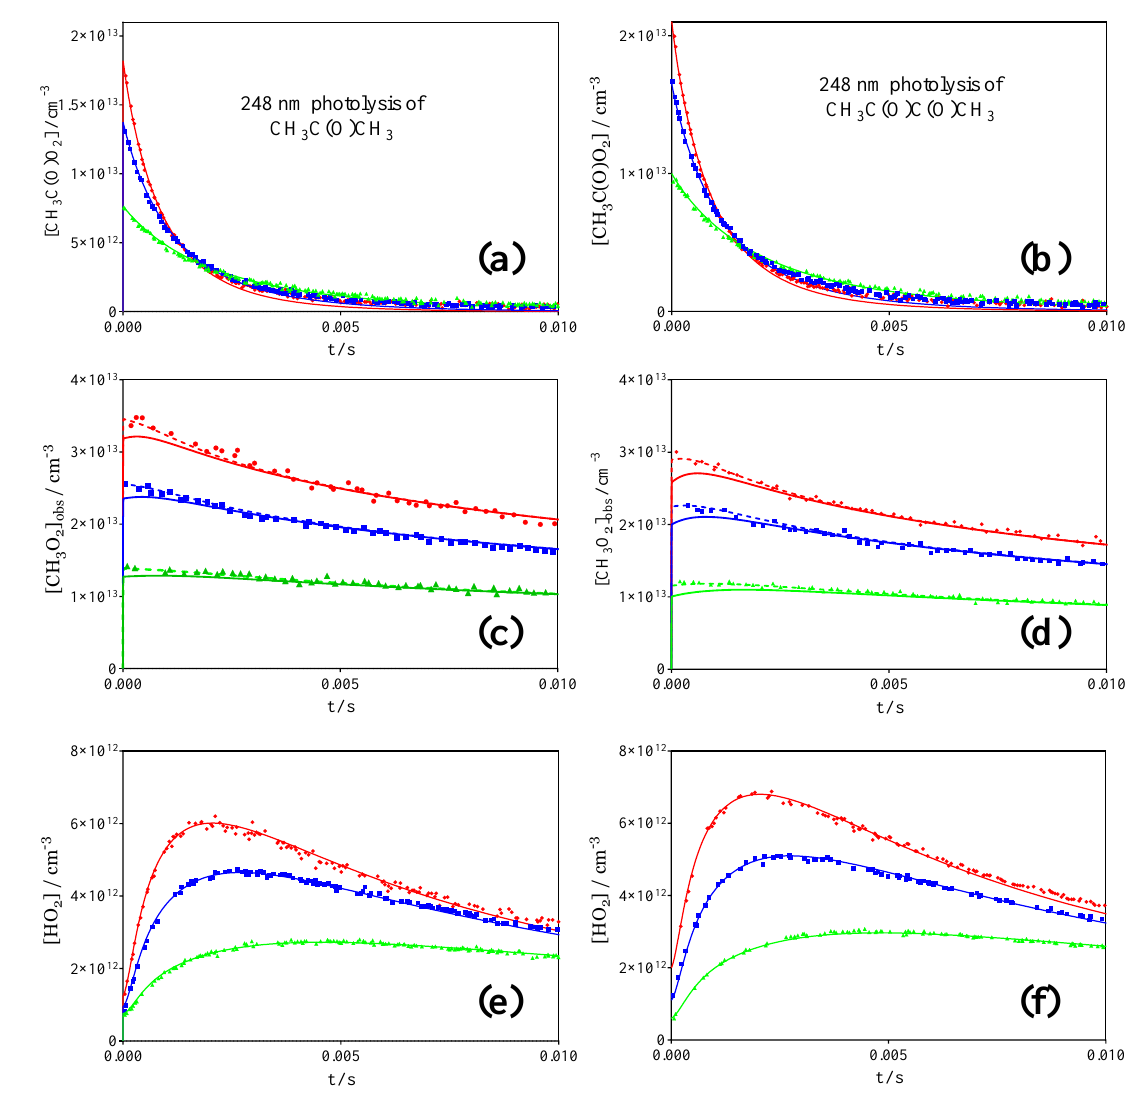
Figure 6. Concentration-time profiles of CH 3 C(O)O 2 • ( a , b ), CH 3 O 2 • ( c , d ) et HO 2 • ( e , f ) measured simultaneously following the 248 nm photolysis of 3 different concentrations of CH 3 C(O)CH 3 [CH 3 C(O)CH 3 ] = 1.21 (red), 0.86 (blue) and 0.4 × 10 16 cm − 3 (green) (left raw) and CH 3 C(O)C(O)CH 3 [CH 3 C(O)C(O)CH 3 ] = 6 (red), 2.56 (blue) and 0.93 × 10 16 cm − 3 (green) (right raw) in 100 Torr O 2 . Full lines: simulation following the model and rate constants as given in Table 3. For the [CH 3 O 2 • ] profiles, the dashed lines show [CH 3 O 2 • ] + 0.179 × [CH 3 C(O)O 2 • ]. Experimental HO 2 • profiles have been decreased by around 10% for the lowest radical concentration, i.e., the model systematically underestimates HO 2 • at low overall radical concentrations.